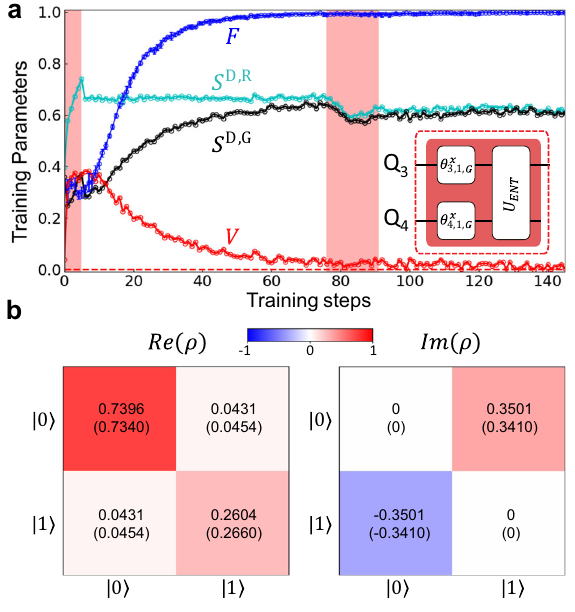
Fig. 2 QGAN performance in learning a mixed state. a Tracking of the loss function V , the output scores S D,R/G , and the state fi delity between R/G ’ s output states F during the adversarial training procedure with learning rates α D = 0.8 and α G = 0.6. The alternate training stages of D and G are marked by red and white regions, respectively. In each stage, the maximum step number is limited to 50 for D and 100 for G. Inset: the quantum circuit for generating ρ R for Q 3 . The same circuit is also used for G, with random initial guesses for the two rotational angles which are then optimized. b Elements of the real and imaginary parts of the output density matrices of R(G). The numbers in the parentheses denotes the corresponding values for